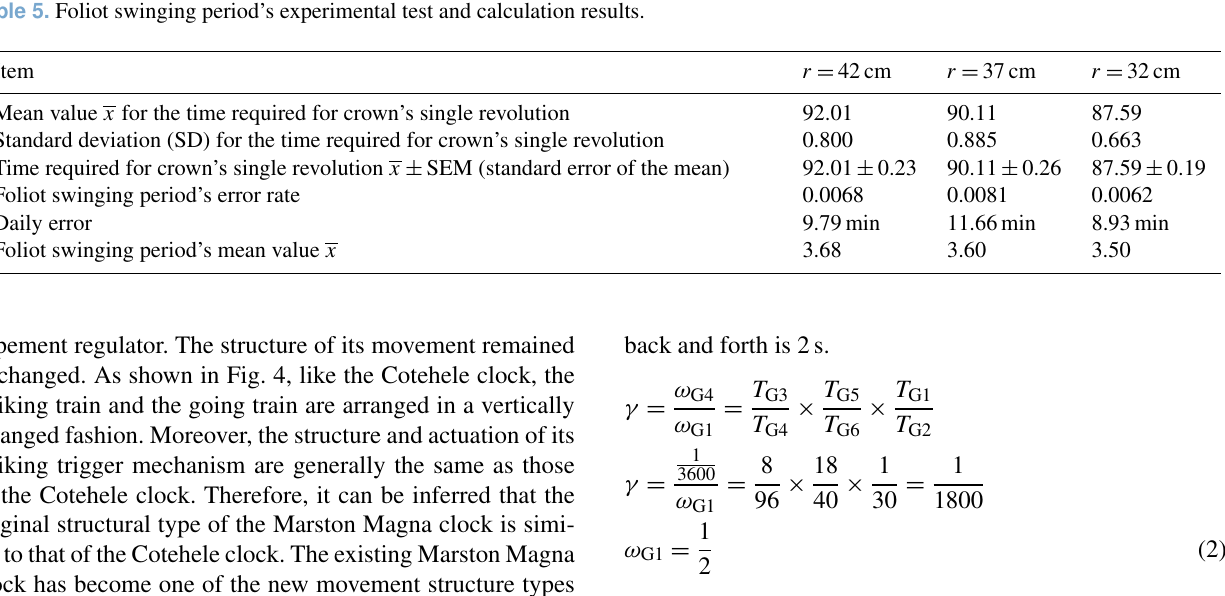
Number of effective revolutions recorded of the crown wheel 144 revolutions